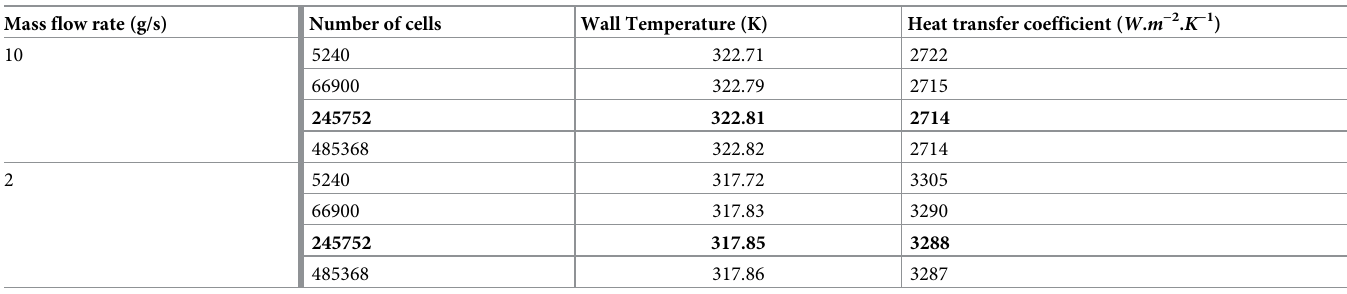
Table 1. Mesh convergence for the straight channel.